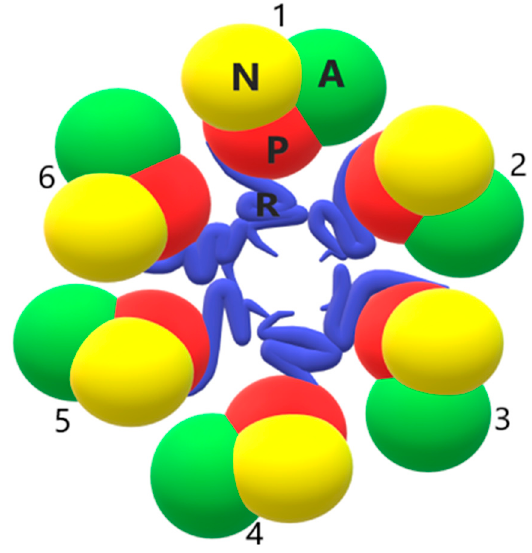
Figure 3. Schematic model of a functional PM H + -ATPase hexamer. The C-terminal regulatory domain mediates subunit–subunit contacts in the hexamer. The numbers 1–6 represent the individual PM H + -ATPase molecules. In each proton pump molecule, the N domain is shown in yellow, the P domain in red, the A domain in green and the R domain in blue. The M domain is omitted from the figure. The figure shows only the arrangement of the N, P and R domains of plasma membrane H + - ATPases during oligomerization.